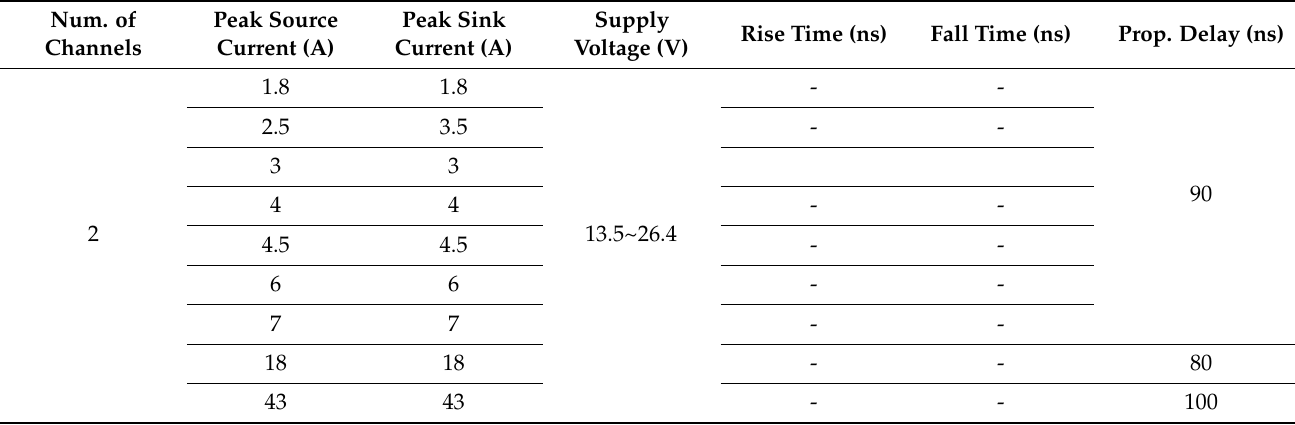
Table 36. Commercial SiC MOSFET drivers by Tamura.